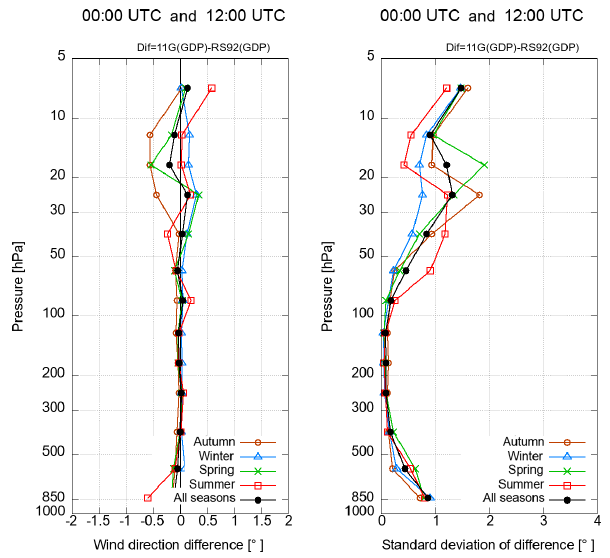
Figure 18. As per Fig. 17, but for wind direction.